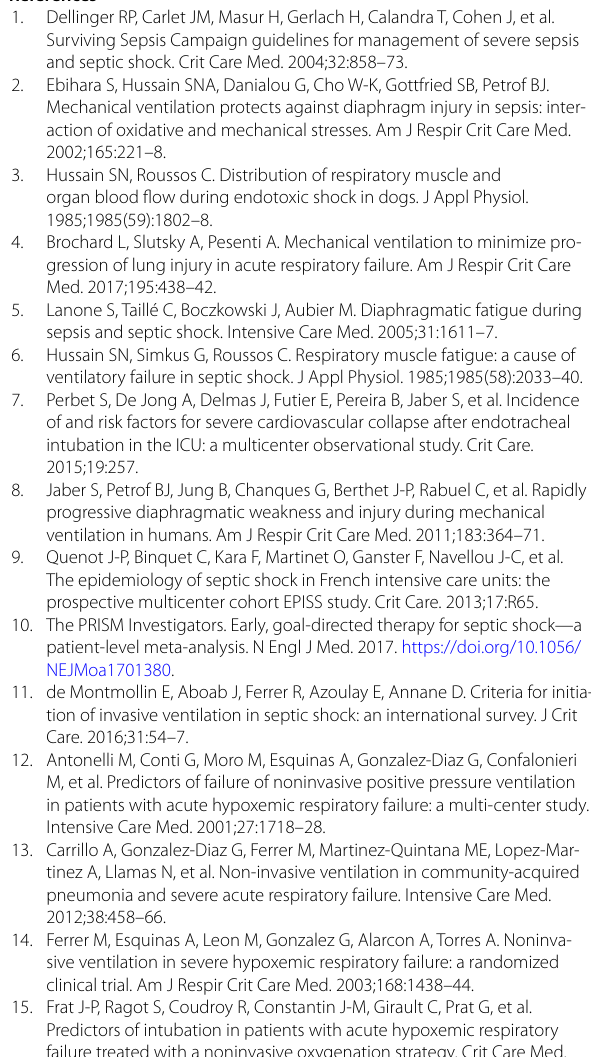
Additional file 1: Table S1. Conversion table for FiO 2 determina‑ tion. Table S2. Comparison between patients intubated early and not intubated early in the group of patients with standard criteria for early endotracheal intubation. Abbreviations ICU: Intensive care unit; PaO2: Arterial oxygen partial pressure; FIO2: Inspired oxygen fraction; SAPS II: Simplified Acute Physiologic parameter; SOFA: Sequential Organ Failure Assessment; VO2: Oxygen consumption; NYHA: New York Heart Association functional classification; PaCO 2 : Arterial carbon